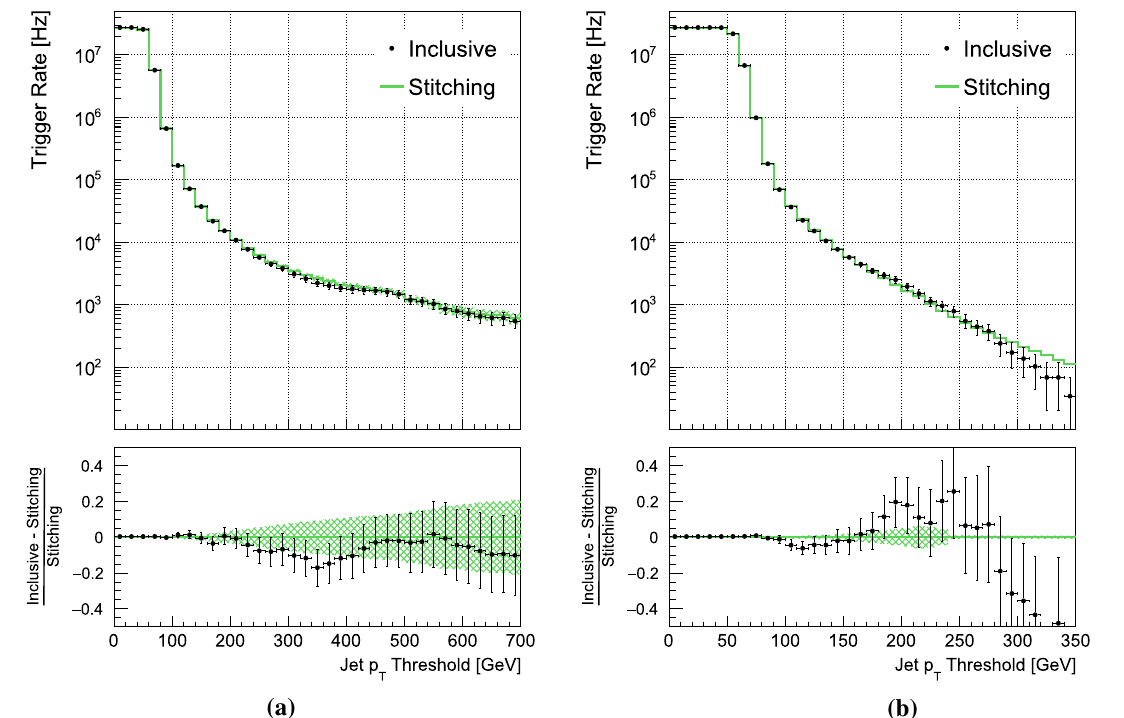
Fig. 5 Rate expected for a a single jet trigger and b a dijet trigger at the HL-LHC, as function of the p T threshold that is applied to the jets